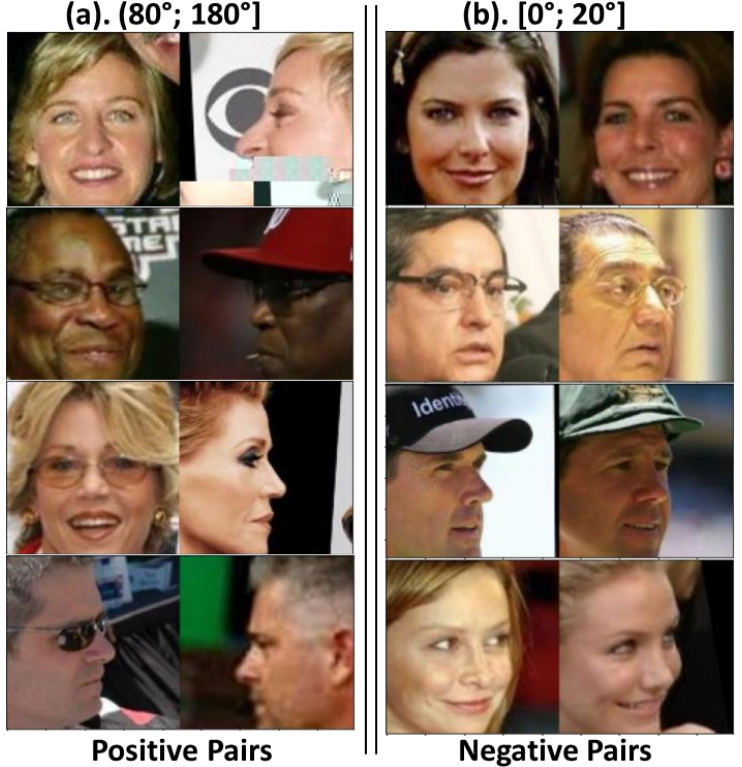
Figure 8. Example of CPLFW image pairs incorrectly classified by